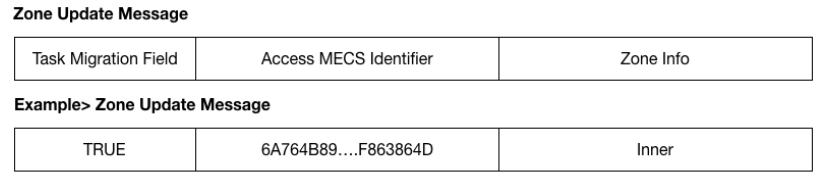
Figure 5. ZU message format and